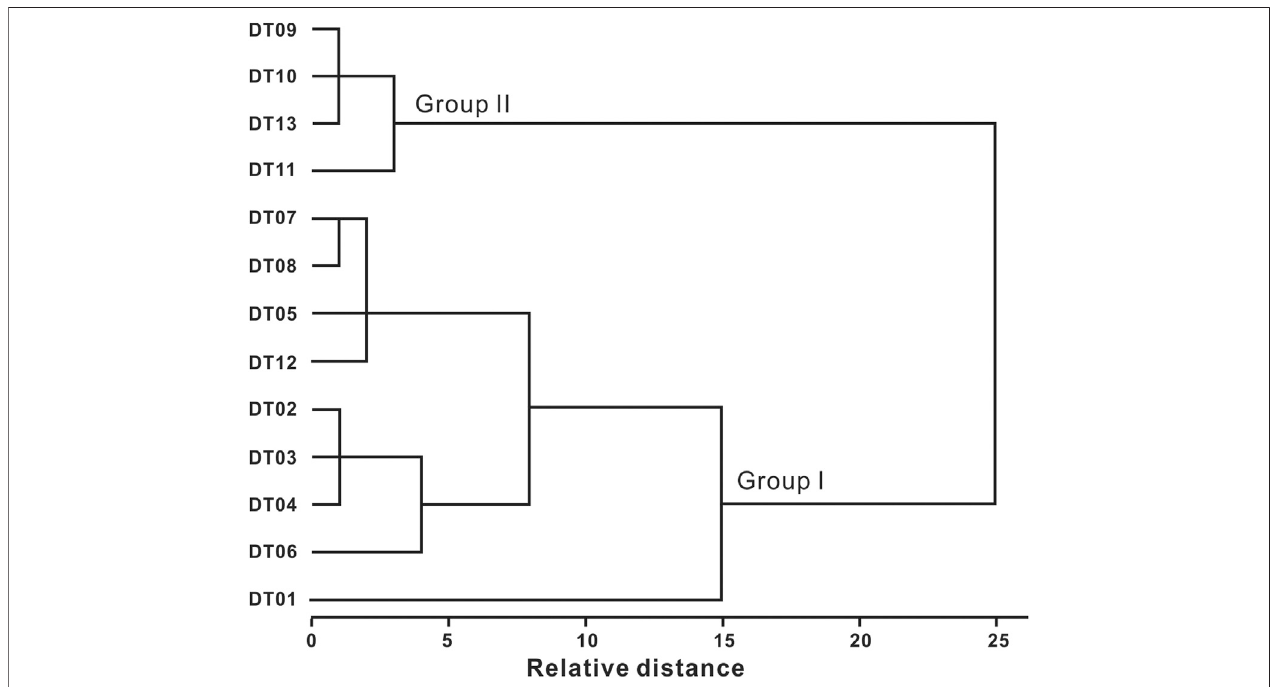
FIGURE 6 | Dendrogram showing the grouping of 13 samples based on the composition of 34 VOCs.